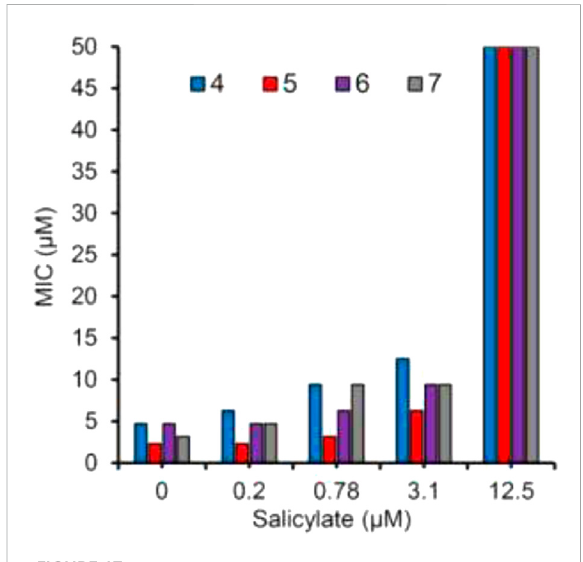
FIGURE 17 Growth sensitivity of M. tb in GAST medium supplemented with salicylate at 0, 0.2, 0.78, 3.1, and 12.5 μ M. Reproduced from Dawadi et al., 2018, with permission from American